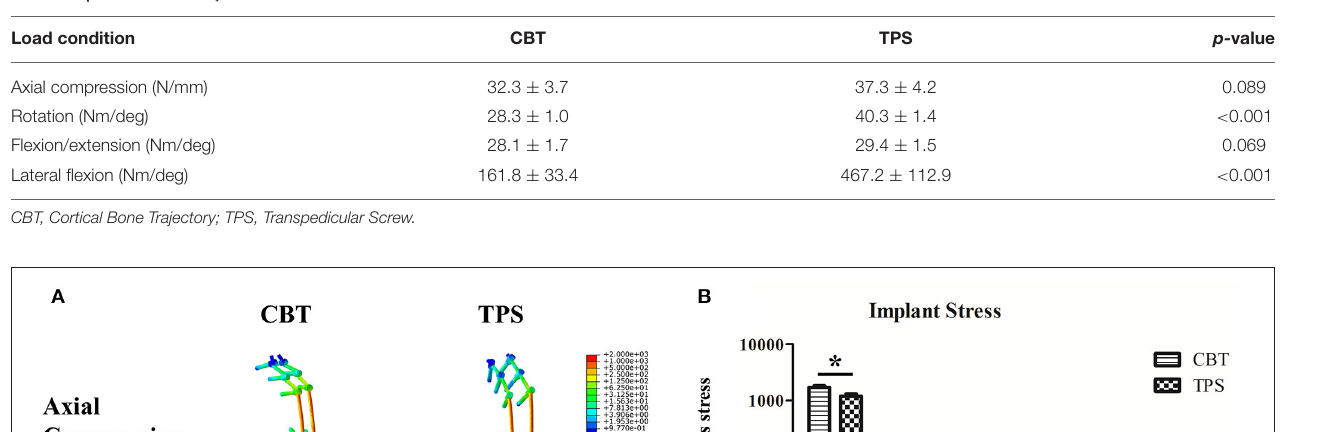
TABLE 3 | The local stability under different load